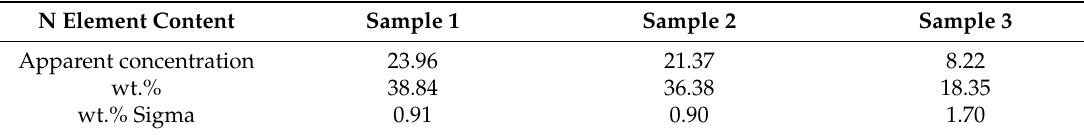
Table 6. N content on the surface of each